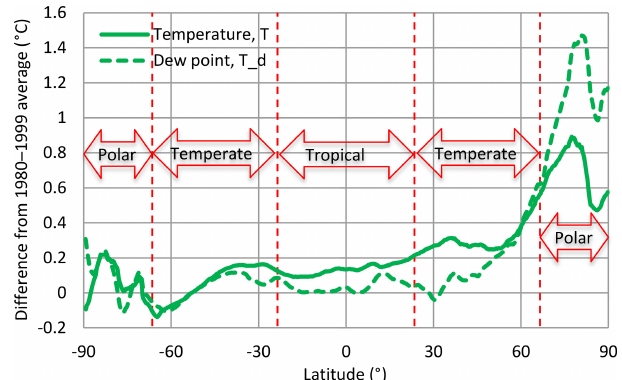
Figure 3. Zonal distribution of the difference of the Earth temper- ature and dew point from their averages in the period 1980–1999. Source of the data set is ERA5 reanalysis, as detailed in Table 1. The data for the plot were constructed via Climexp by first com- puting “anomalies” for the period 1980–1999, then by computing zonal mean and finally by applying the option to “Compute mean, standard deviation, or extremes” and specifying “averaging over 12 months”. Note that the graph represents averages for the entire period of over 40 years, rather than differences between two periods (the latter are about twice the